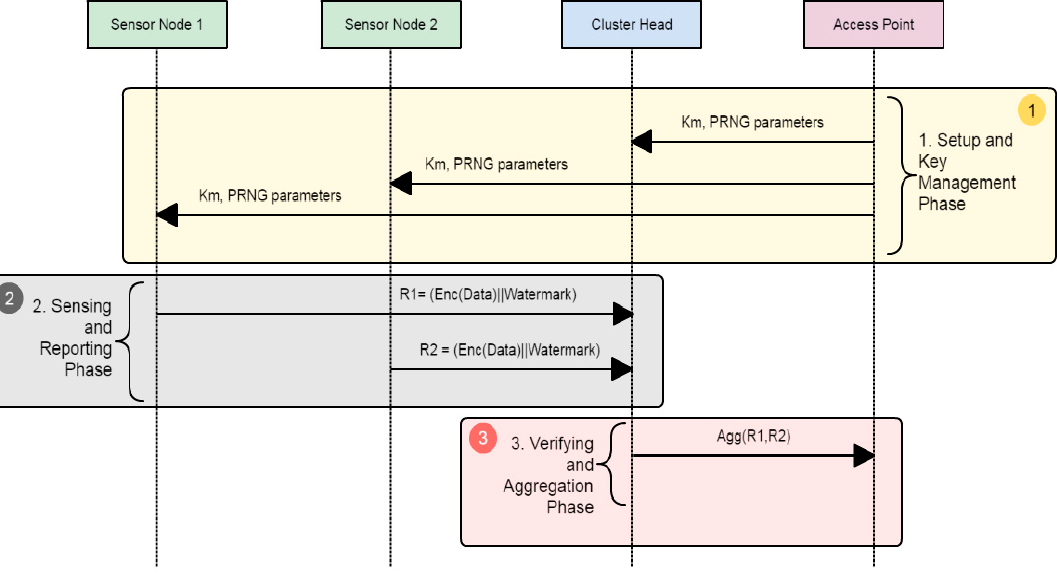
Figure 3. The sequence diagram of the proposed scheme. Table 1. System notation.